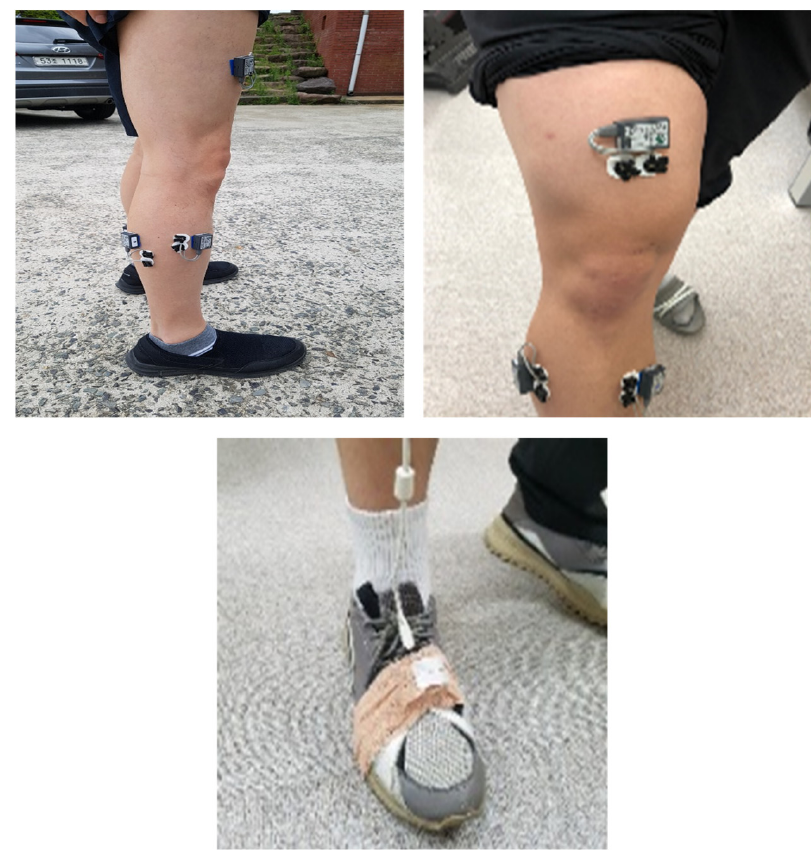
Figure 3. Illustration of the sensors location on right foot.